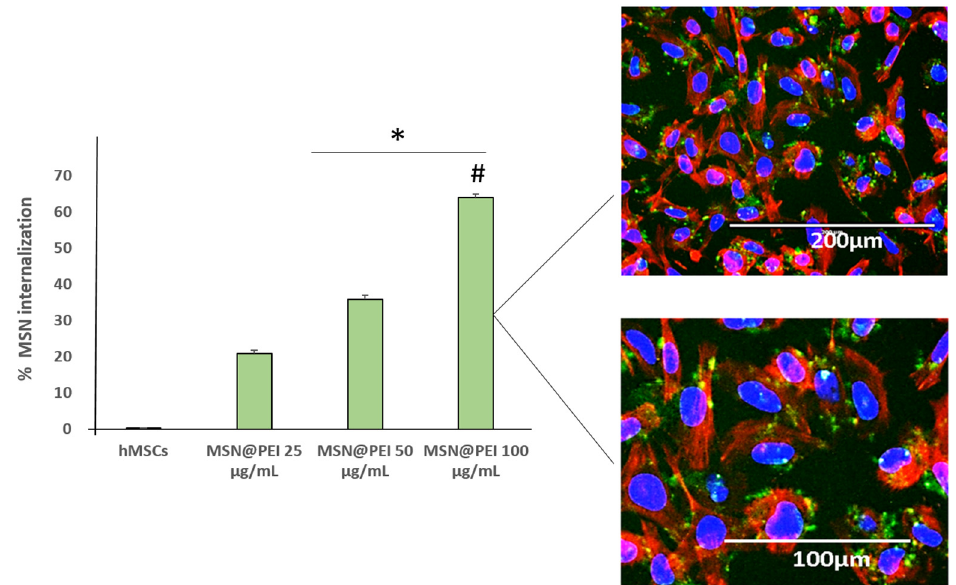
Figure 6. MSN-nanosystem internalization by human Mesenchymal Stem Cells (hMSC) using flow cytometry and fluorescence microscopy. The cellular uptake of different Fluorescein-labeled MSNs and MSN@PEI was measured at 25, 50, and 100 µ g/mL by flow cytometry at 2 h of internalization